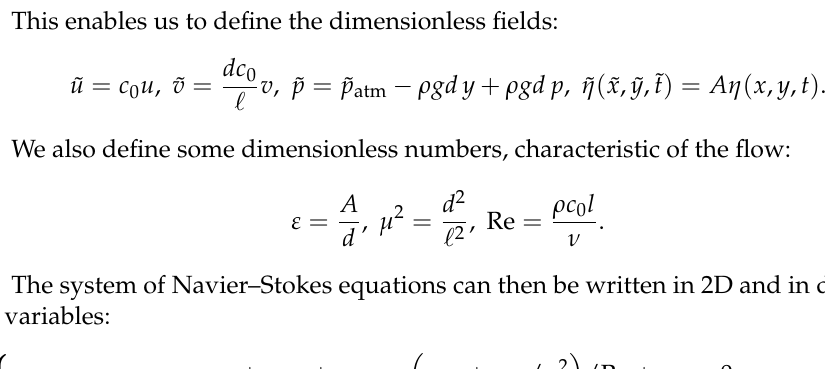
Figure 1. Sketch of the fluid